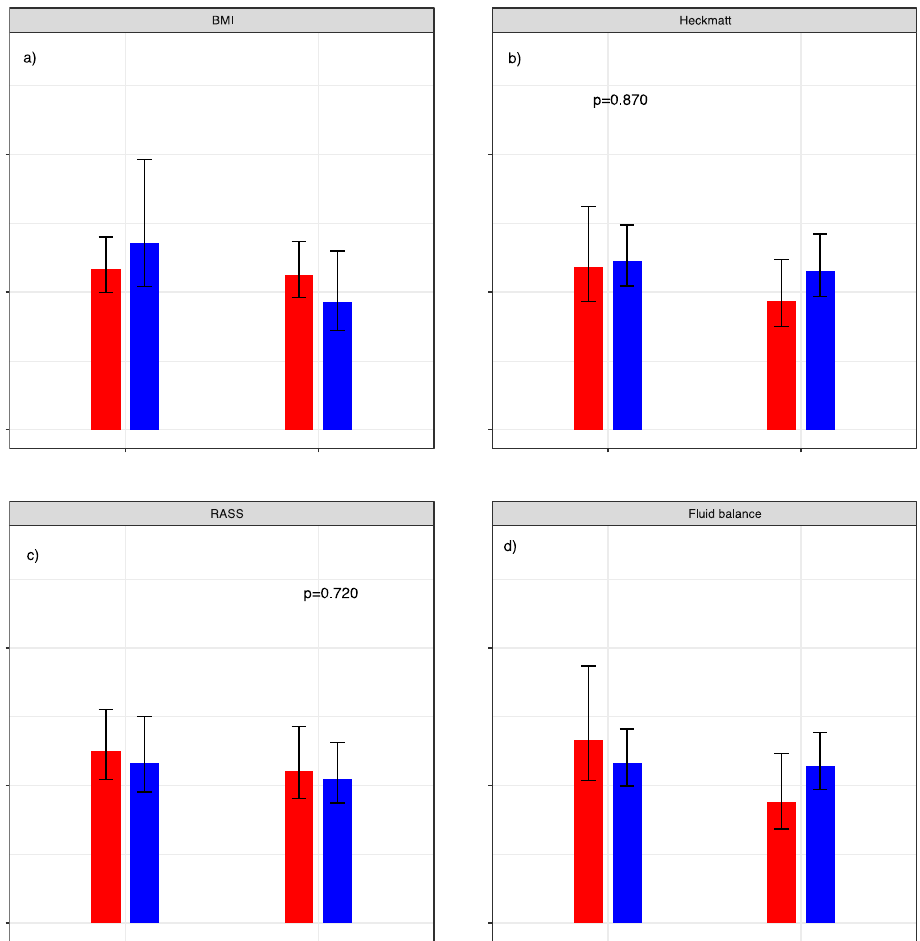
Figure 5. Standard error of measurement relative to patient characteristics. SEM with dichotomization of ( a ) BMI: red graphs represent < 30 versus blue graphs ≥ 30. ( b ) Heckmatt score: red graphs represent cohort with values < 3 and blue graphs ≥ 3. ( c ) RASS score: red graphs represent cohort with values < 0 und blue graphs ≥ 0. ( d ) Fluid retention normalized to body weight: red graphs represent cohort with values < 7.5% (red) versus blue graphs ≥ 7.5%. p -values for the calculated F-test are given above the respective graphs.